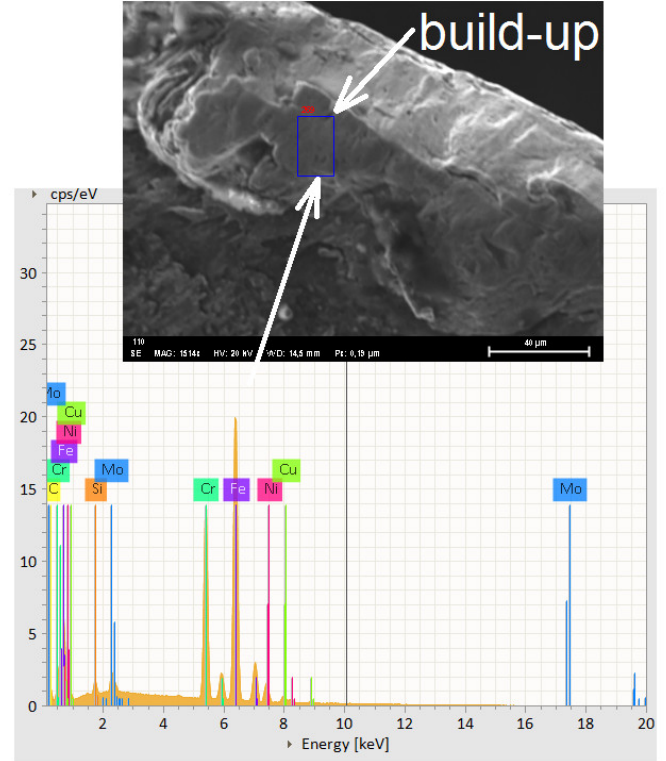
Figure 8. The examples of tool wear measurements by SEM: ( a ) flank wear and ( b ) rake face wear.